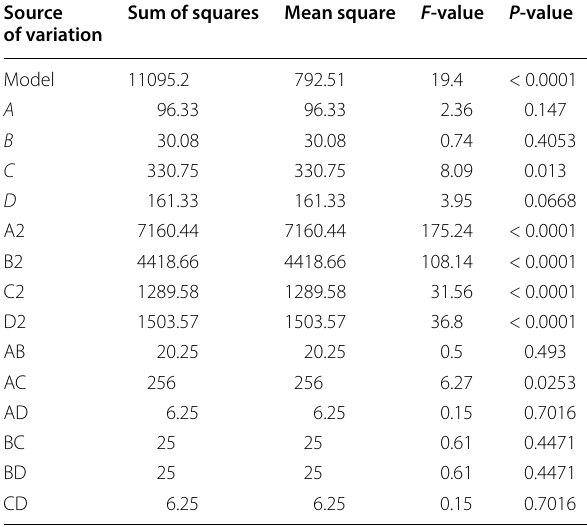
Table 2 Analysis of variance (ANOVA) for Bacillus drentensis strain S1 degrading APAP Source Sum of of variation